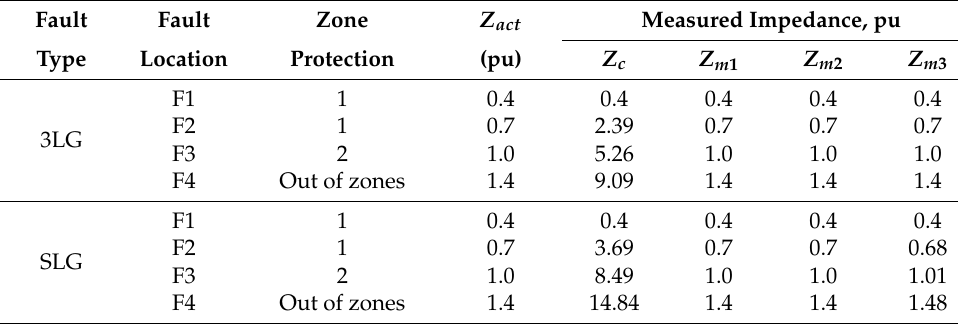
Table 1. Distance relay performance under varying system